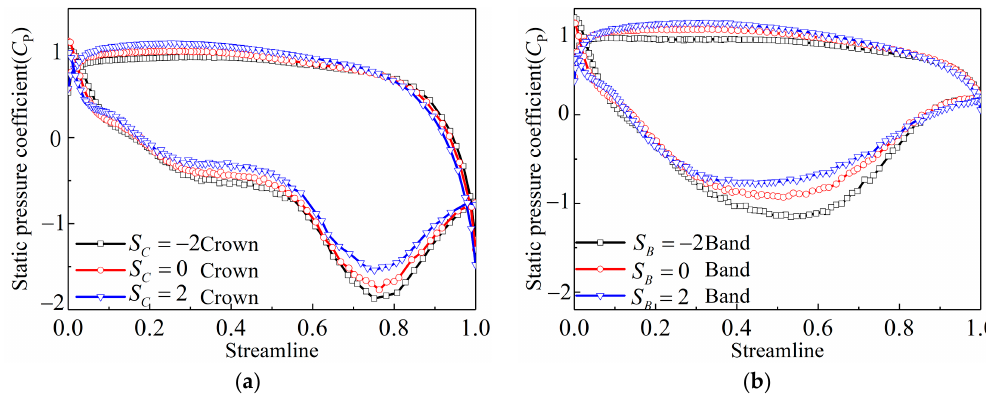
Static pressure coefficient distributions at the band.